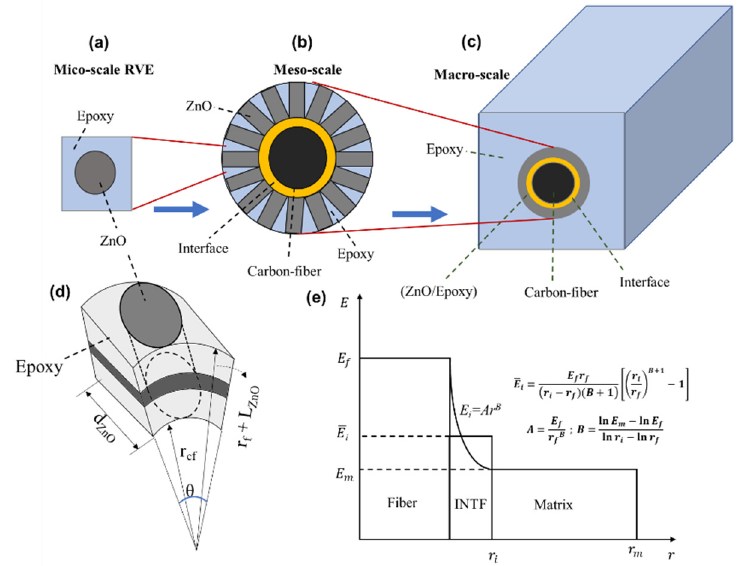
Figure 7. Schematic of ( a,d ) RVE used for homogenization of ZnO/epoxy layer; ( b ) radially aligned ZnO on the fiber and embedded in epoxy; ( c ) different phases containing fiber, interface, coating layer, and epoxy; ( e ) distribution of interface stiffness.